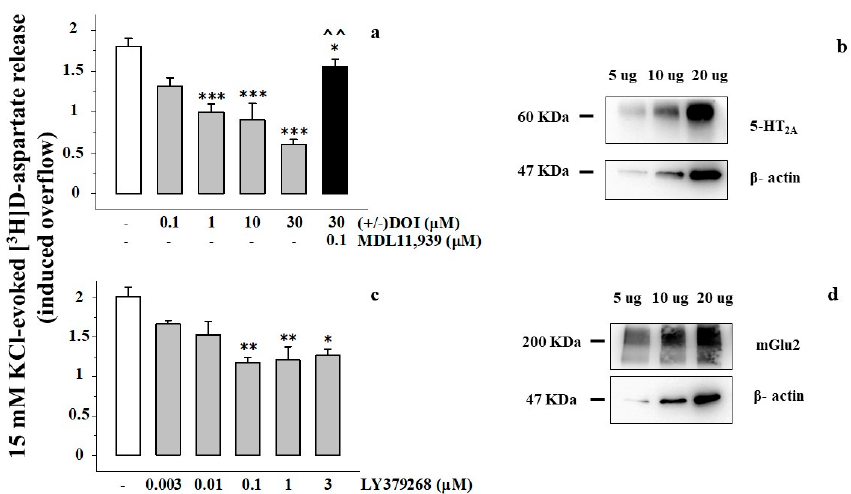
Figure 1. Effects of ( ± ) DOI and of LY379268 on the 15 mM KCl-evoked release of preloaded [ 3 H]D- aspartate ([ 3 H]D-asp) from synaptosomes isolated from the prefrontal cortex (PFc) of adult rats. ( a ) ( ± ) DOI (0.1–30 µ M) inhibits the exocytosis of ([ 3 H]D-asp) elicited by 15 mM KCl-enriched medium. Synaptosomes were exposed in superfusion to the depolarizing stimulus for 90 s in the absence or in the presence of the 5-HT 2A receptor agonist. When indicated, the 5-HT 2A antagonist MDL11,939 (0.1 µ M) was added concomitantly to ( ± ) DOI. The release of [ 3 H]D-asp in the first 3 min fraction collected (b1) amounted to 0.33 ± 0.02 nCi and represents the 0.90 ± 0.05% of the total tritium synaptosomal content. ( b ) PFc synaptosomes are endowed with the 5-HT 2A receptor protein. Synaptosomal lysates were immunoblotted and probed with anti-5-HT2A and anti- β -actin antibodies. ( c ) LY379268 concentration-dependently (0.003–3 µ M) reduced the [ 3 H]D-asp exocytosis elicited by high K + from synaptosomes isolated from the PFc of adult rats. The release of [ 3 H]D-asp in the first 3 min fraction collected (b1) amounted to 0.49 ± 0.06 nCi and and represents the 0.77 ± 0.12% of the total tritium synaptosomal content. ( d ) Western blot analysis confirming the presence of mGlu2 receptor protein in the PFc lysates. Synaptosomal lysates were immunoblotted and probed with anti-mGlu2 and anti- β -actin antibodies. ( a , c ) results are expressed as induced overflow; data are the means ± SEM of four to six experiments run in triplicate (three superfusion chambers for each experimental conditions). * p < 0.05 vs. respective 15 mM KCl; ** p < 0.01 vs. respective 15 mM KCl; *** p < 0.001 vs. respective 15 mM KCl; ˆˆ p < 0.01 vs. 15 mM KCl/30 µ M ( ± ) DOI. The blots in ( b , d ) are representative of 5 to 7 blots run in different days using different samples. Table 1. Effects of ketanserin on the release of [ 3 H]D-aspartate elicited by 15 mM KCl in the absence or in the presence of ( ± ) DOI.